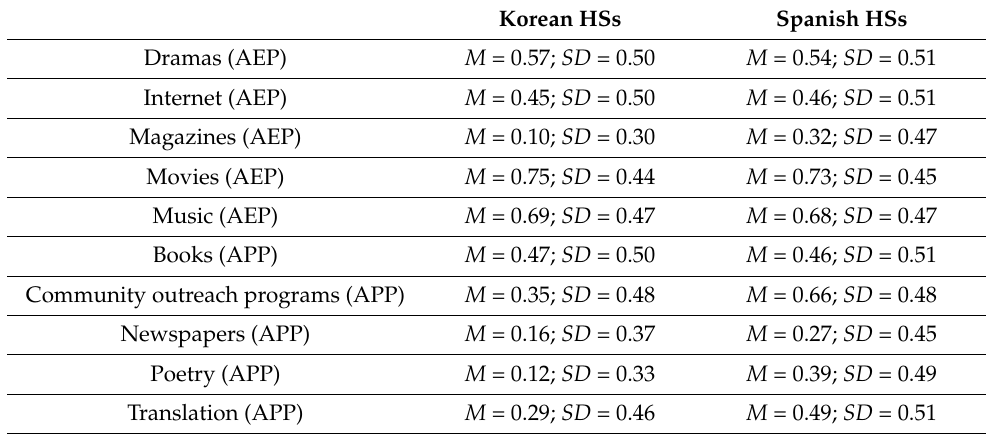
Figure 2. Activity/material type preferences across HL groups. Participants were also asked if they considered their HL an asset that could bring success to their careers. All Spanish HSs ( n = 41) responded affirmatively while the Korean HSs’ responses were not as categorical: 67% ( n = 34) considered that their HL would bring success to their career, 31% ( n = 16) responded negatively, and one participant did not answer. A generalized linear mixed model including the Korean HSs’ responses to this question as dependent variable, their self-rated proficiency as fixed factor, and ‘partici- pant’ as a random effect determined that their responses were modulated by proficiency ( β = 0.83, SE = 0.43, z = 2.43, p = 0.02). This indicates that Korean HSs whose HL proficiency